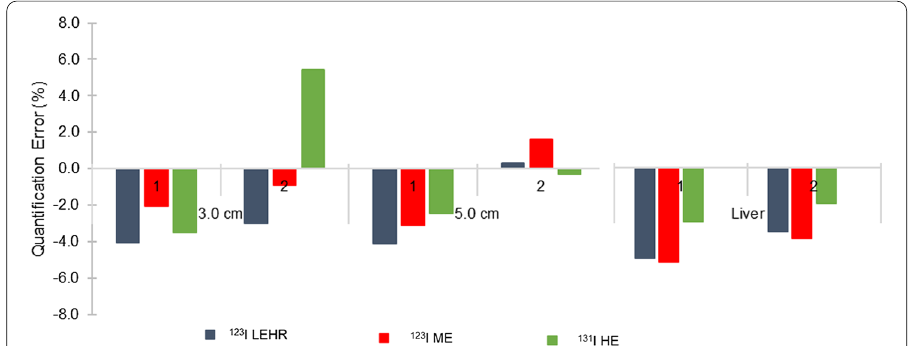
Fig. 8 Activity quantification errors (%) for spheres in the voxel-based digital patient phantom (scenario 1 and 2), for 123 I LEHR, 123 I ME and 131 I